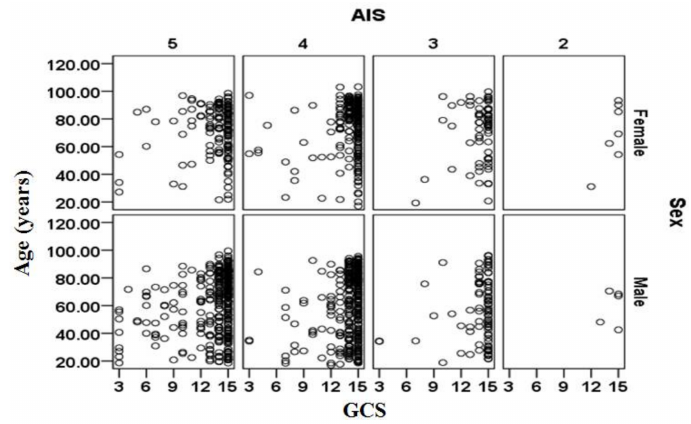
Figure 3. Relationships between age, sex, abbreviated injury score (AIS) and Glasgow coma score (GCS) for the subjects included in the validation dataset that survived.